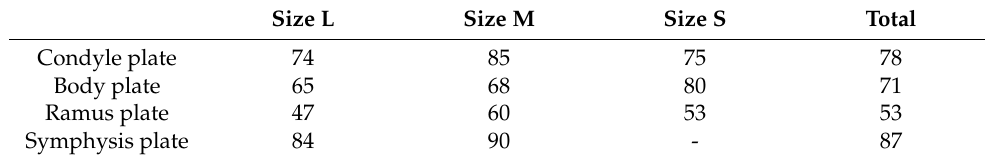
Table 1. Fitting accuracy in percentage of the preformed osteosynthesis plates of the mandible.